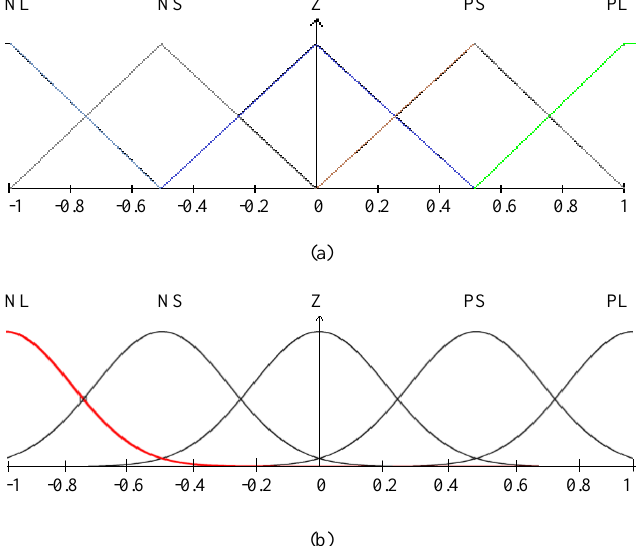
(b) Fig. 6. Membership function plot for the fuzzy logic controller inputs: NS – negative small, NL – negative large, Z – zero, PS – positive small, PL – positive large: (a) input triangular membership function, (b) output Gaussian membership